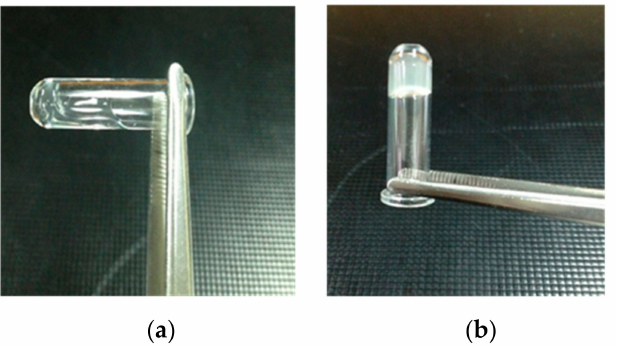
Figure 14. Derived from blood separation, plasma exhibits a fluid and a static states ( a ) before and ( b ) after an agglutination reaction,